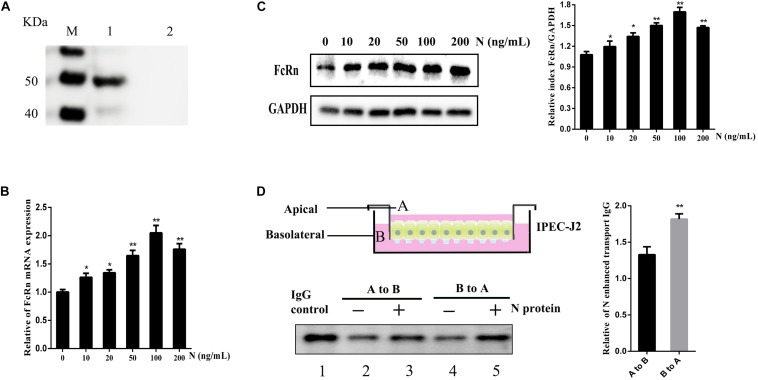
Effects of recombinant TGEV N stimulation on the IgG transcytosis in IPEC-J2 cells. (A) Analysis of recombinant TGEV N protein by Western blot. M: Protein marker. 1: TGEV recombinant N. 2: Negative Control. IPEC-J2 cells were treated with recombinant TGEV N protein (0, 10, 20, 50, 100 or 200 ng/mL) for 12 h. (B,C) FcRn expression levers were detected by RT-qPCR and Western blot. The right panel represents the quantification of the bands by densitometry, corrected by the amount of GAPDH. (D) Transwell system used throughout this study. A, apical; B, basolateral. IPEC-J2 cells were grown in a 12-well transwell plate about 6–7 day until TEER > 1000 Ω/cm2. IPEC-J2 cells were stimulated with or without recombinant TGEV N (100 ng/ml) for 12 h. Cells were loaded with porcine biotin-IgG at 37°C in either the apical (lanes 2 and 3) or basolateral (lanes 4 and 5) chamber. Lane 1 represents an IgG. ∗p < 0.05, ∗∗p < 0.01.